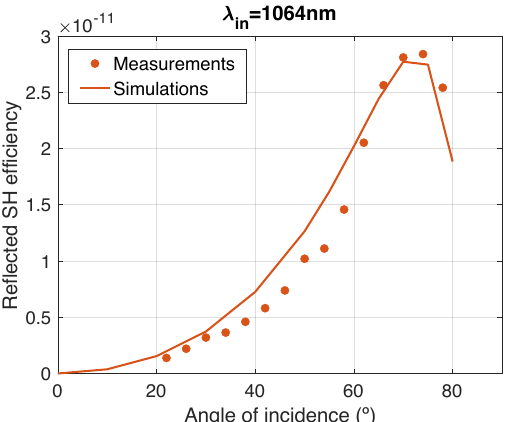
Fig. 3. Measured (full circles) and predicted (solid curves) SHG transmitted efficiencies as a function of the angle of incidence from the 70nm-thick Au layer when the incident pulse is tuned at